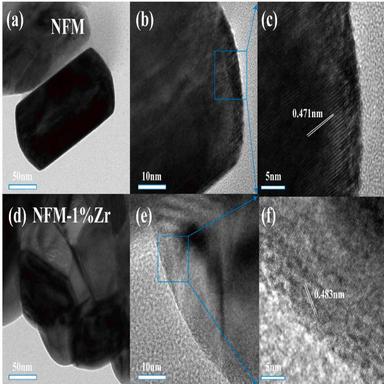
TEM images of (a, b, c) NFM and (d, e, f) NFM-1 %Zr samples.